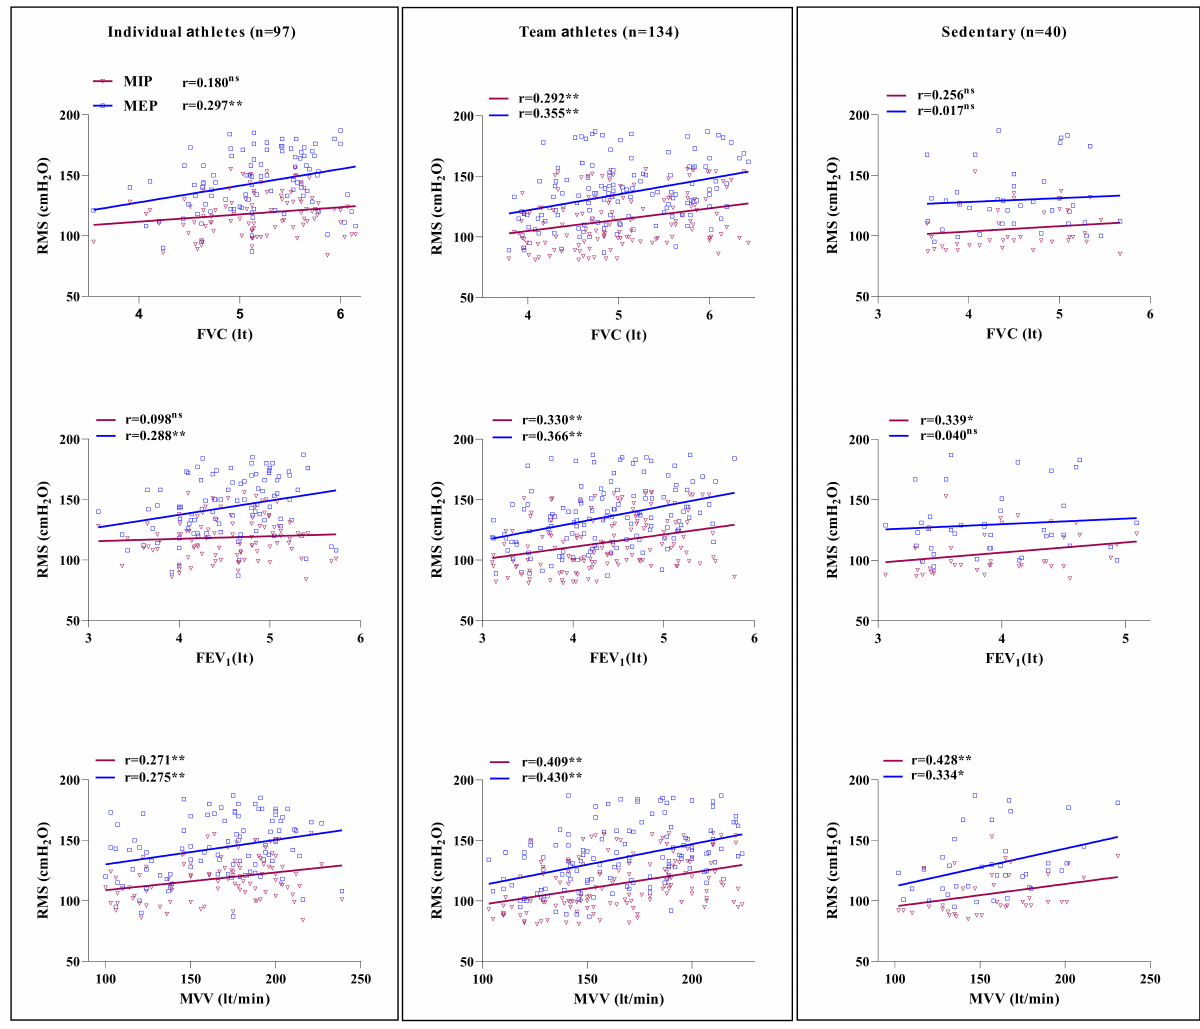
Fig. 4. The correlation between respiratory muscle strength and pulmonary functions according to sports disciplines. * p < 0.05; ** p < 0.001; ns, non-significant; RMS, Respiratory muscle strength; MIP, Maximal inspiratory pressure; MEP, Maximal expiratory pressure; FVC, Forced vital capacity; FEV 1 , Forced vital capacity at 1 second; MVV, Maximal voluntary ventilation.